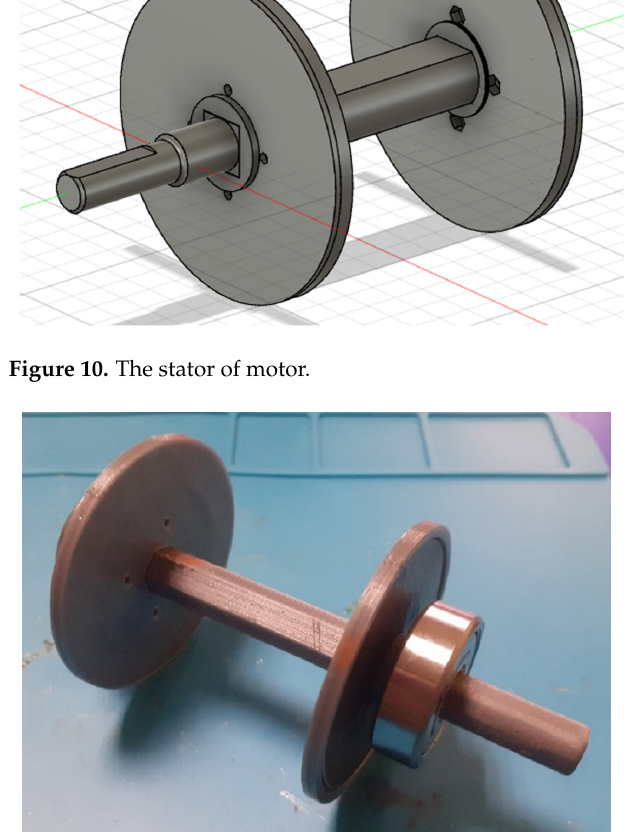
Figure 11. The rotor model of motor.